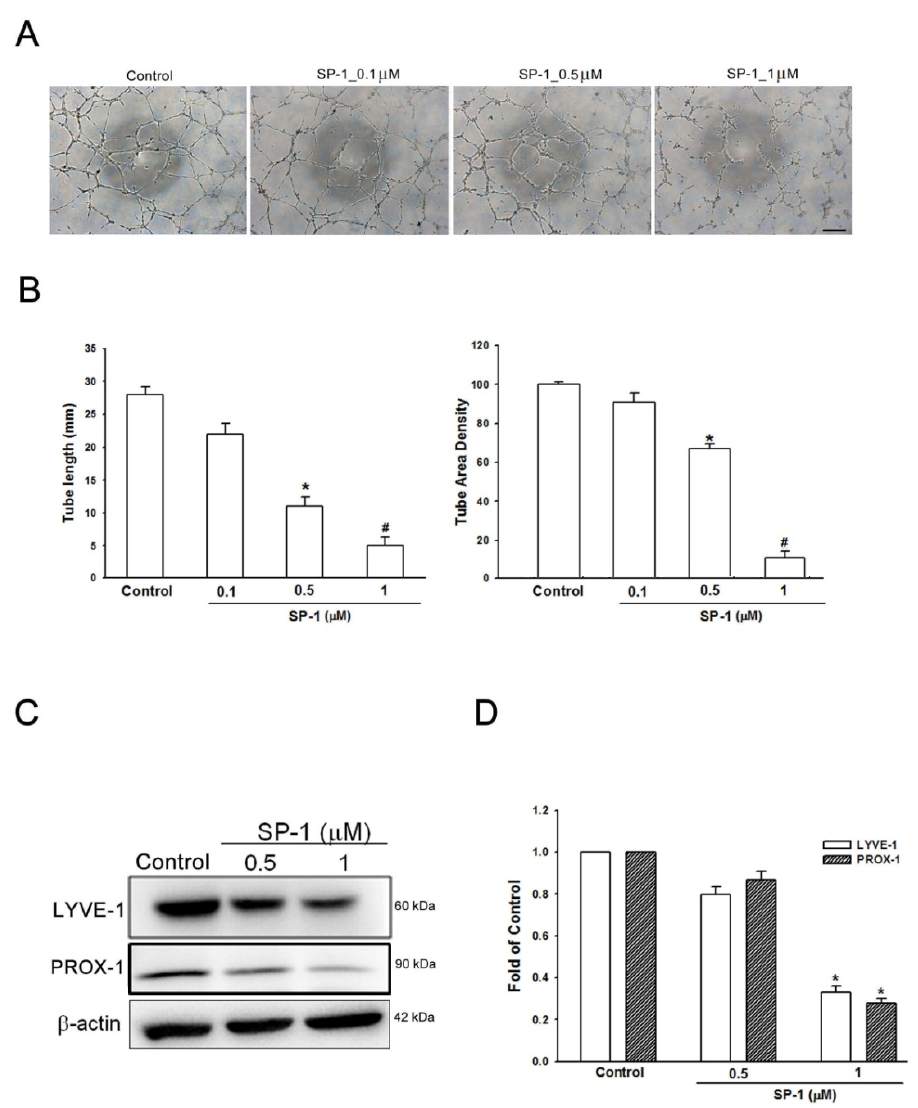
Figure 6. Heteronemin suppressed the tube formation, migration and phosphorylation of VEGF- C/VEGFR-3/LYVE-1 in human lymphatic endothelial cells. ( A ) Cells were treated with the indicated concentrations of heteronemin (indicated as SP-1). The capillary-like structure formation was examined by tube formation (scale bar = 500 μ m; 20 × magnification). ( B ) The quantification of tube formation was performed using Image-J to validate the anti-lymphangiogenic property of SP-1. ( C ) LECs were treated with SP-1. Then, the expression of LYVE-1and PROX-1 was determined by Western blot analysis. ( D ) The quantitative densitometry of the relative levels of LYVE-1 and PROX-1 was measured by Image-Pro Plus. Data are expressed as the mean ± SEM of at least three independent experiments. * p < 0.05; # p < 0.01 compared with the control group.